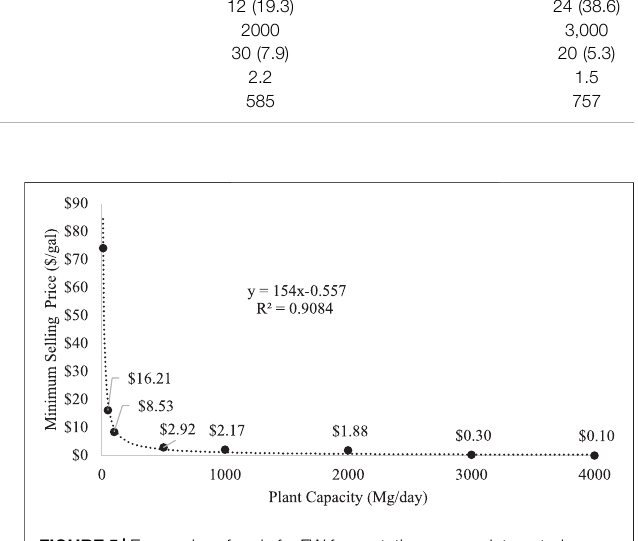
FIGURE 5 | Economies of scale for FW fermentation process integrated with